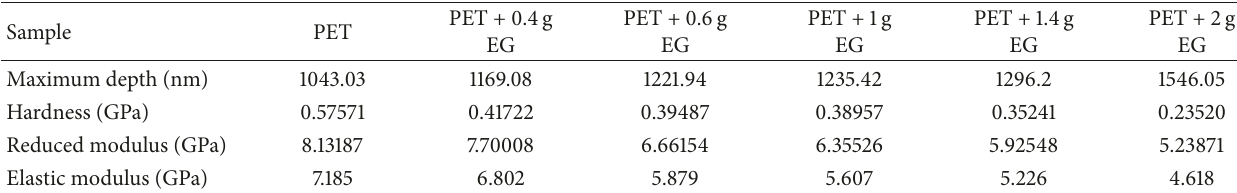
Table 3: Nanoindentation results of all samples.